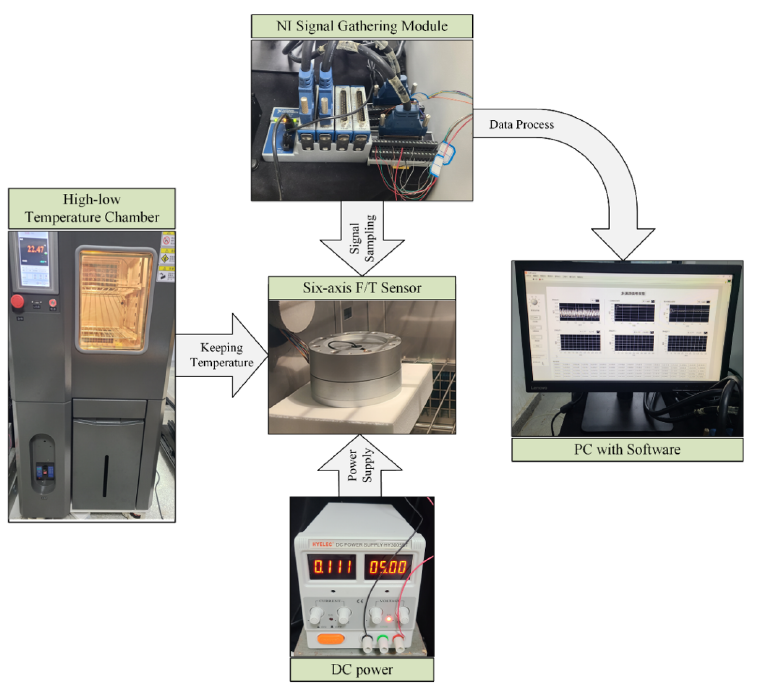
Figure 2. Temperature experiment